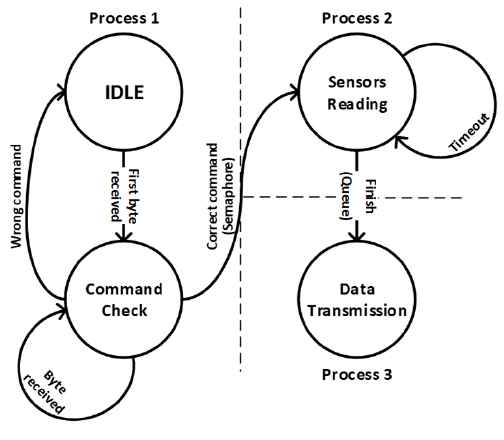
Figure 5. States